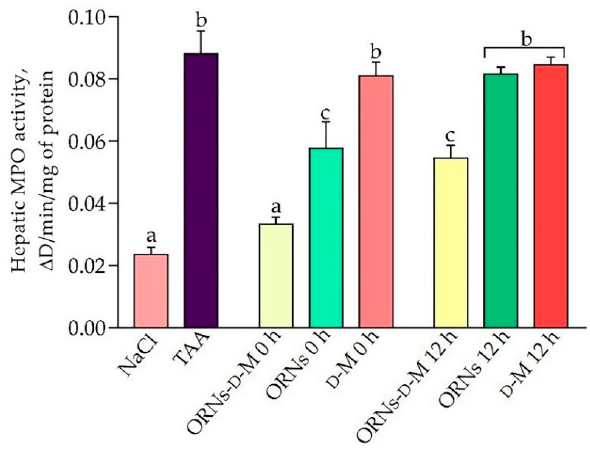
Figure 2. Effects of ORNs- D -M, ORNs and D -M on the MPO activity in TAA-induced liver damage mice. Data are presented as the mean ± SD, n = 6 for each group. Values marked with different letters (a, b, c, d) are statistically different, p < 0.05 (Student’s t -test). Abbreviations: NaCl—control mice receiving a single injection of NaCl; TAA—mice receiving a single injection of TAA; ORNs- D